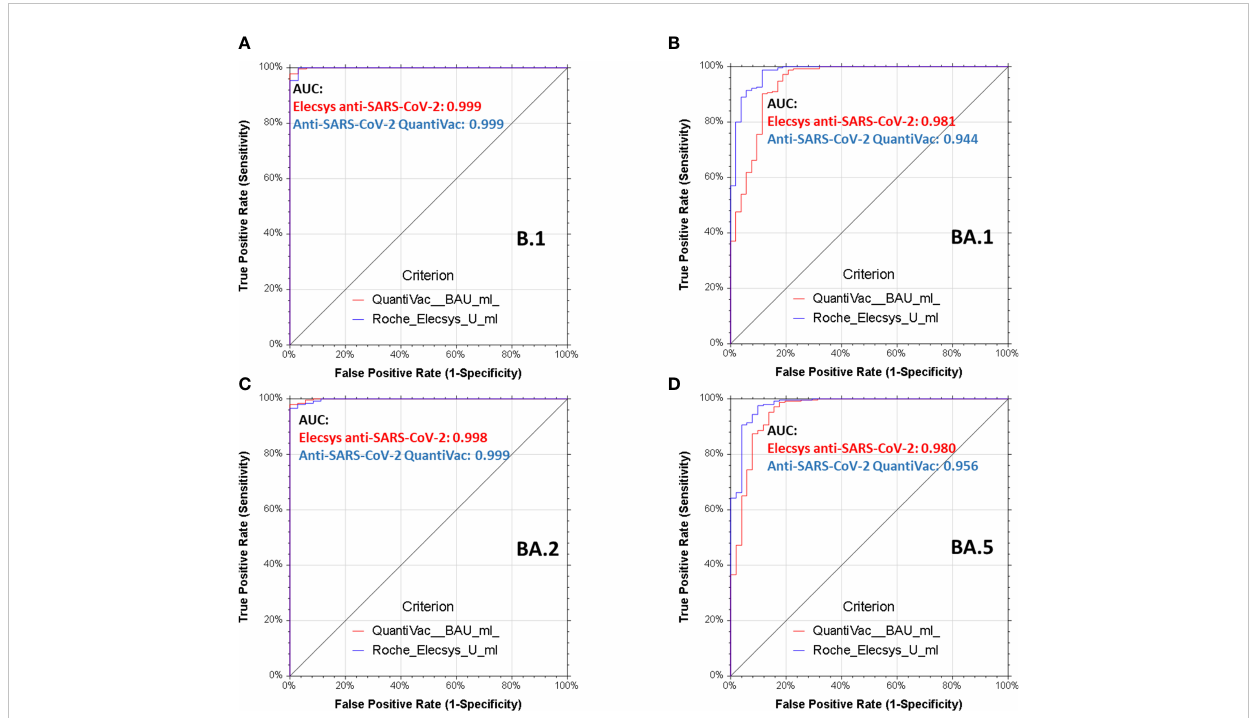
FIGURE 5 Receiver operating characteristics analyses of serological assays and neutralization of spike variants. Receiver operating characteristics (ROC) analyses of Elecsys Anti-SARS-CoV-2 S (red lines) and anti-SARS-CoV-2-QuantiVac-ELISA (IgG) (blue lines) prediction of neutralization of B.1 (A)